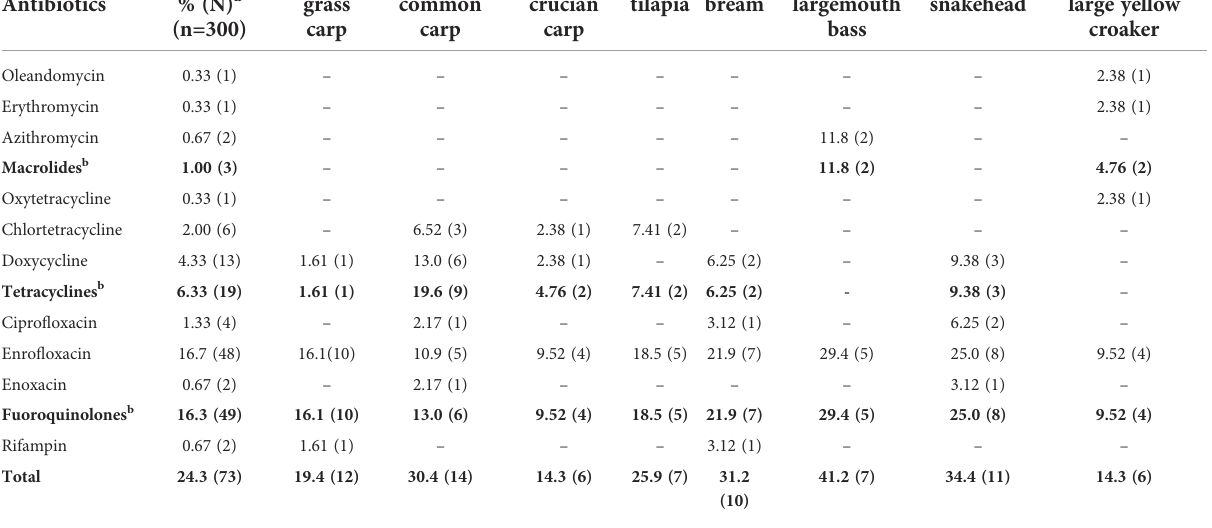
TABLE 1 Detection frequency of antibiotics in different fi sh